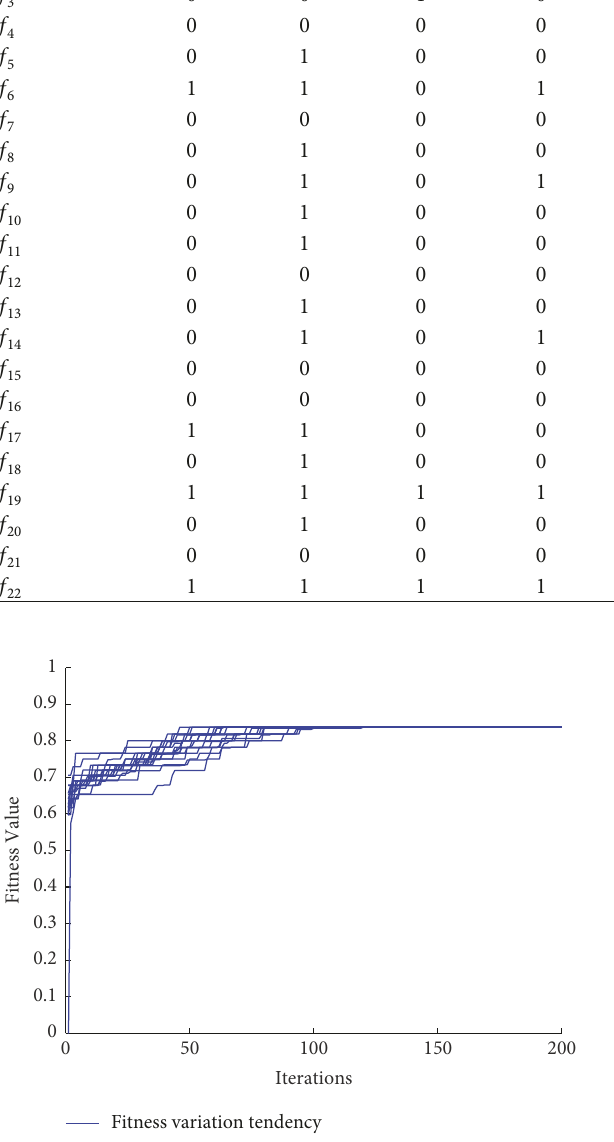
Figure 2: The fitness convergence curve of the superheterodyne receiver